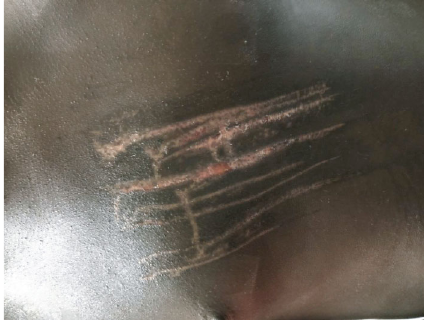
Figure 1: Abrasion marks on the anterior chest wall secondary to blunt chest trauma.